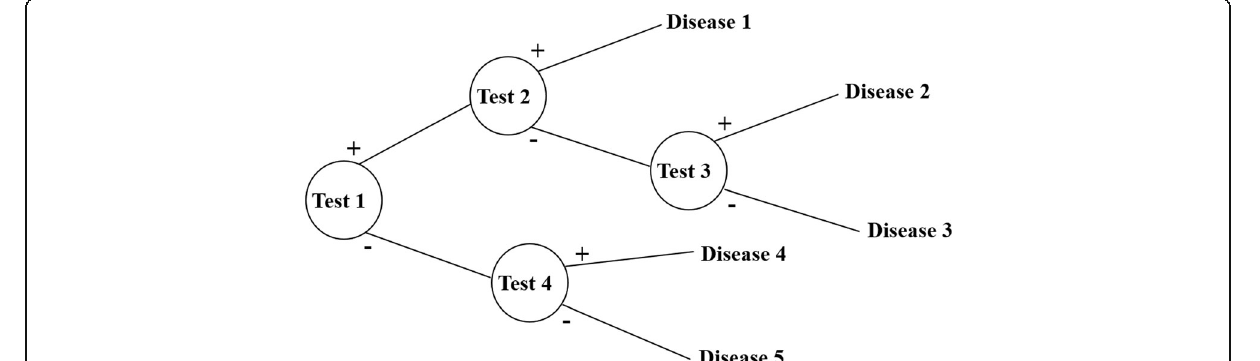
Fig. 1 Probabilistic decision tree for the machine-learning algorithm in diagnostic tests and disease